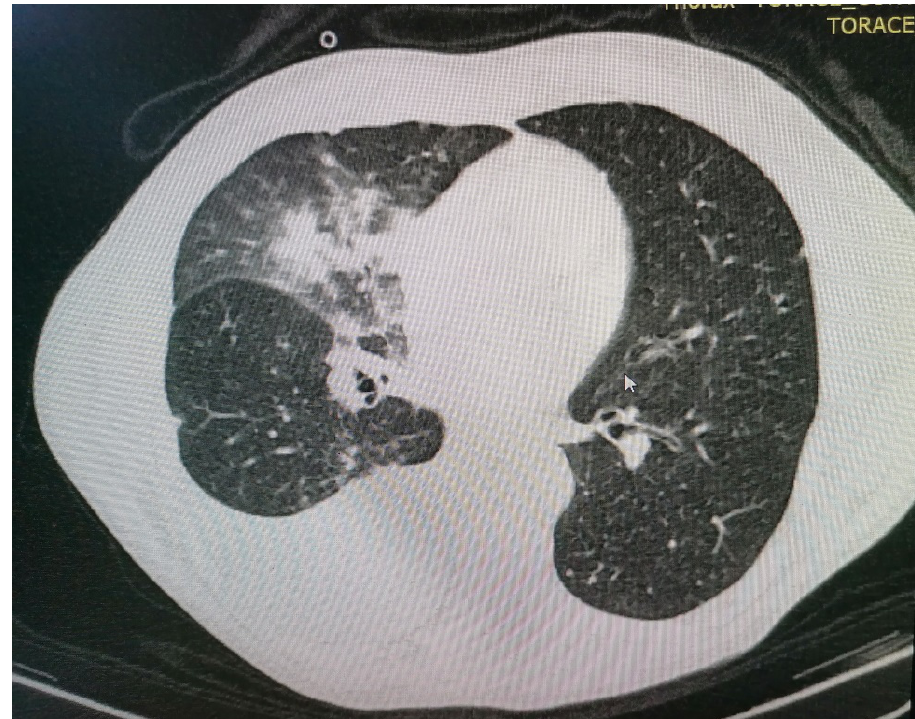
Figure 4. Computer tomography of the patient. We observed a fibrous, sequelae-like plaque which is visible antero-basal right paracardiac; the right pleura with the medium amount; the volume of the left heart cavities aregreatly enlarged (Figure 5).